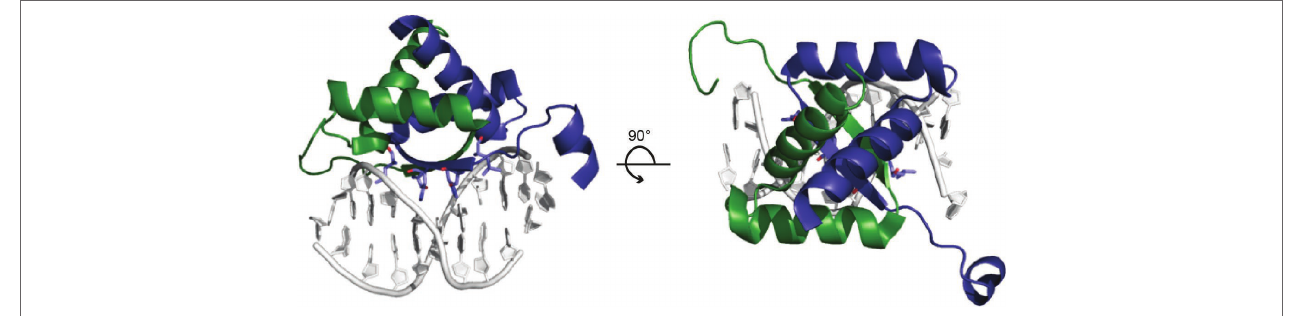
FIGURE 8 | Structure of the ArtA-DNA complex (PDB: 3GXQ). ArtA, the master regulator of the plasmid pSK41, exhibits a ribbon-helix-helix fold. The dimeric repressor is shown in cartoon representation, with chains A and B colored in green and blue, respectively. The anti-parallel β -ribbon permeates the major groove of the binding-site DNA and exerts base-specific interactions (left panel). The view along the twofold axis of the ArtA dimer and the pseudo-palindromic double- stranded DNA site is shown in the right